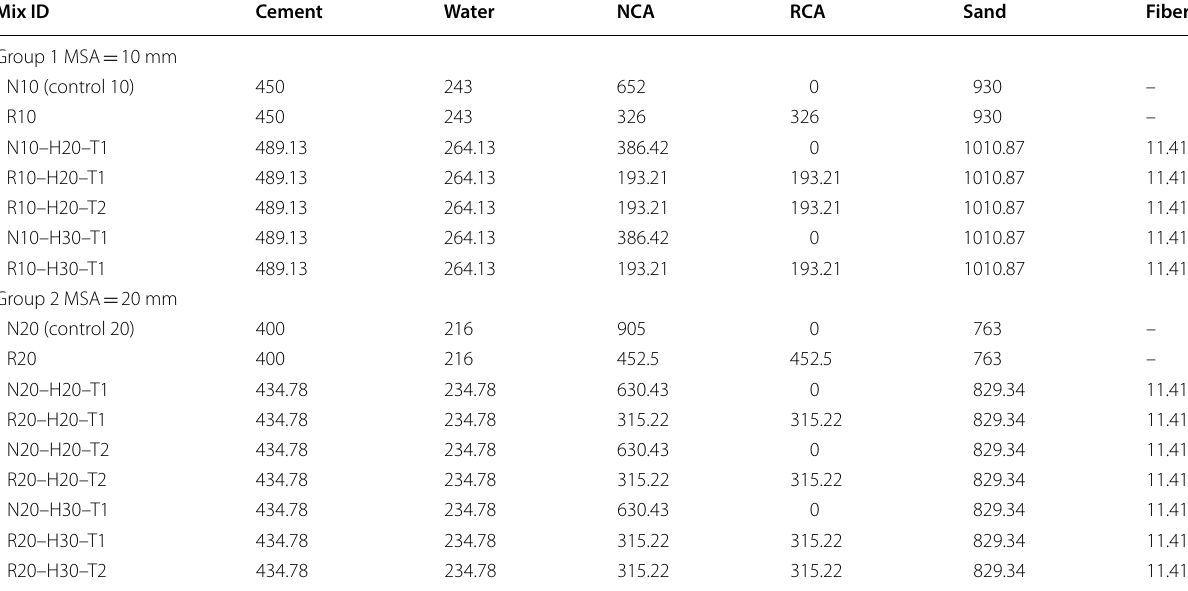
Table 3 Batching weights for all mixes in kg per cubic meter of